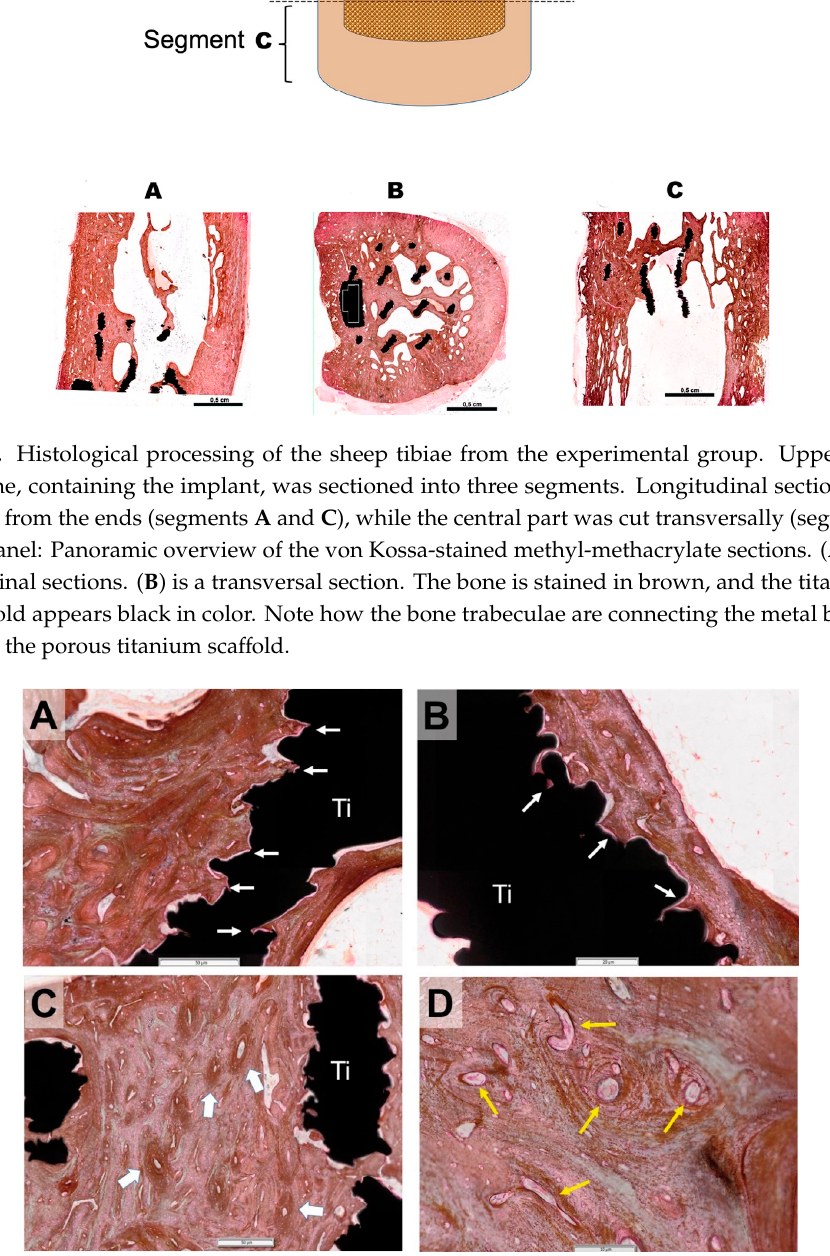
Figure 6. Details of von Kossa-stained bone sections showing the bone scaffold interface. ( A , B ) The bone is deposited directly on the titanium (Ti), with no fibrillar tissue in between. The bone fills all the little cavities and interstices of the scaffold surface (arrows). ( C ) The bone remodeling is appreciable by the occurrence of new osteons overlapping the previously formed bone (thick arrows). ( D ) Numerous blood vessels are visible in the newly formed bone (yellow arrows). Bars: 50 µm in A and C, 20 µm in B, and 10 µm in D. Newly grown bone trabeculae not only surrounded the metal bars that conformed the titanium scaffold, they also bridged them, creating a network of interconnected bone and titanium trabeculae